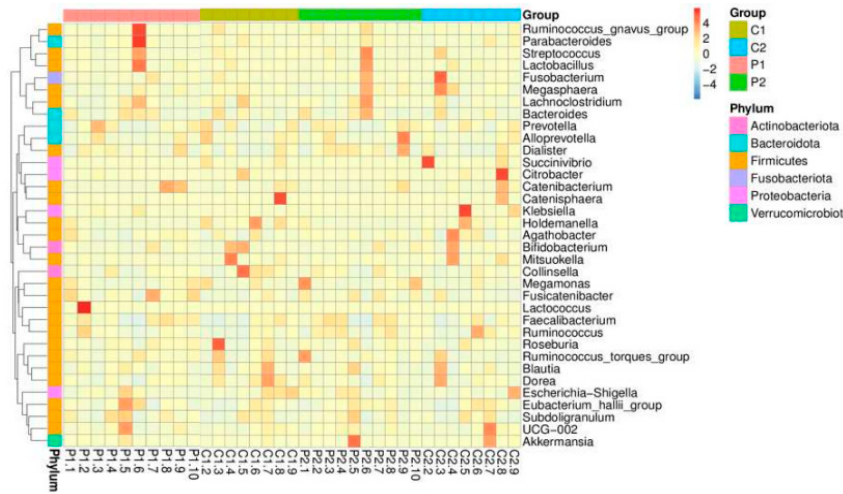
Figure 3. Heatmap of the top 35 relative abundances of each subject and group at the genus level.